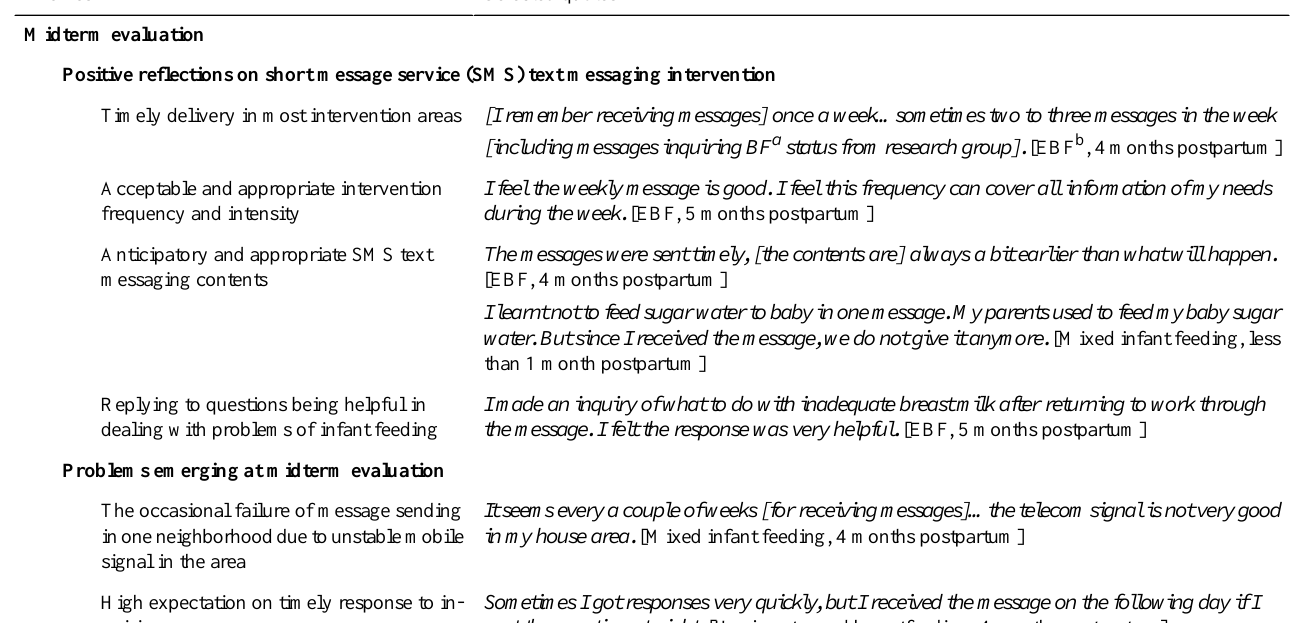
Selected quotesThemes